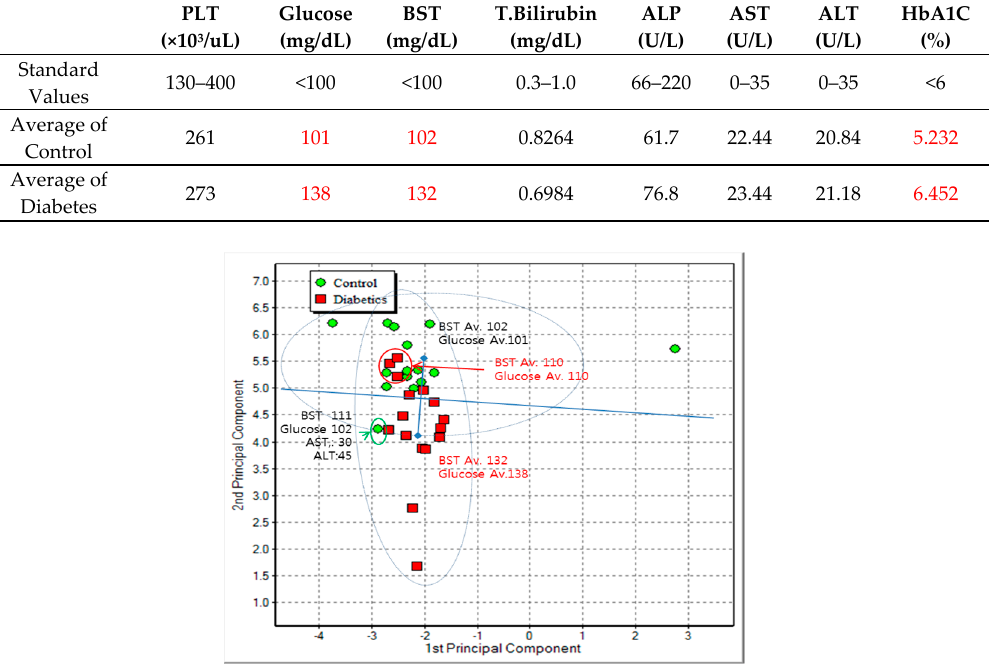
Figure 3. PCA result between diabetics and controls using breath